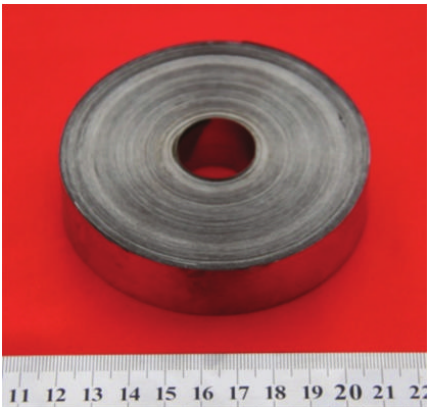
Figure 3: XRD patterns of melt spinned specimens before and after heat treatment (1100 ∘ C/5h +